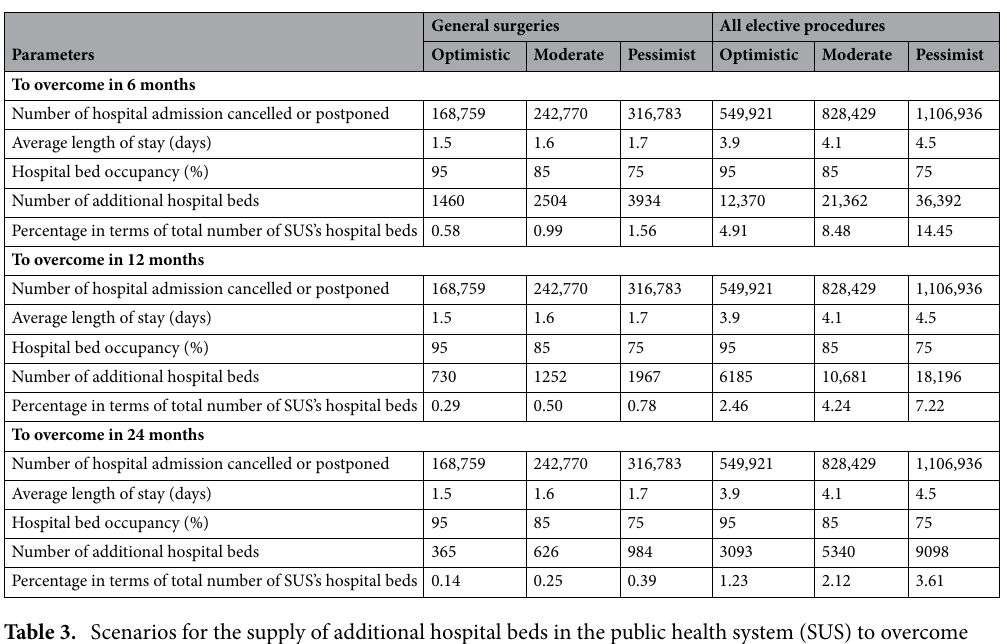
Table 3. Scenarios for the supply of additional hospital beds in the public health system (SUS) to overcome the cancelled or postponed general surgeries and all elective procedures in 2020, Brazil. The number of hospital admissions unattended in 2020 was based on uninterrupted time series’ results, with optimistic, moderate and pessimist scenario based on lower-limit of the 95% confidence interval, average effect, and upper-limit of the 95% confidence interval, respectively. The average length of stay was based on monthly data from 2019, using the same rationale for defining scenario as described in the case of number of hospital admission unattended. The number of months to overcome the unattended procedures was defined arbitrarily. The hospital bed occupancy measures the percentage of beds that in fact was used during the period analysed; occupancy lower than 100% can be explained by hospital management failure, patient desistance or clinically unwell; the Brazilian Ministry of Health recommend an occupancy rate from 75 to 85%, which we used as pessimist and moderate scenario, respectively 19 . We used the total number of hospital beds in SUS on December 2019, totalling 294,968 hospital beds in